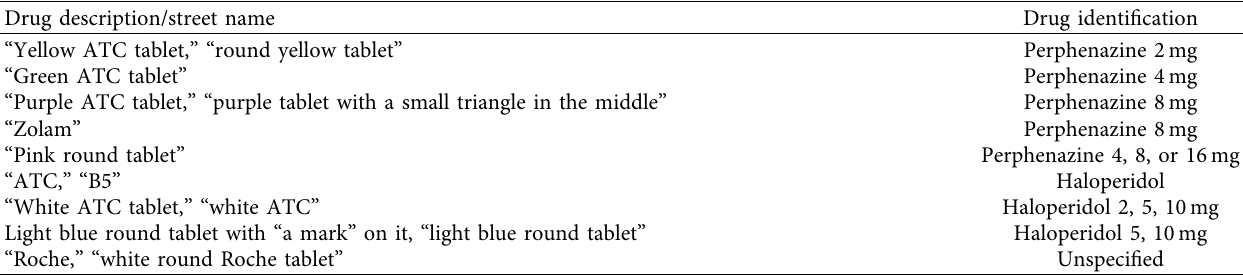
Table 1: Drug characteristics reported by patients and corresponding drug identifcations.